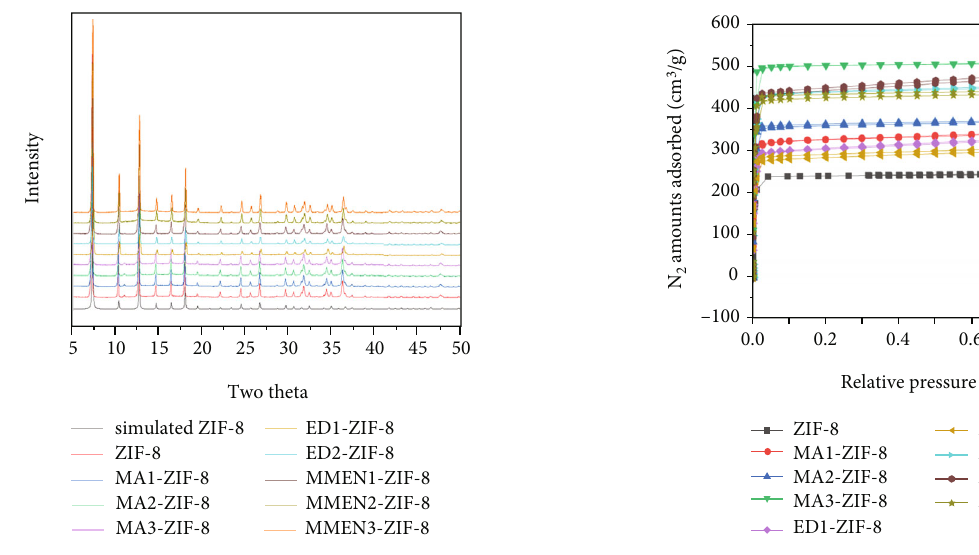
Figure 1: PXRD patterns of ZIF-8 and amine-modi fi ed ZIF-8 samples.